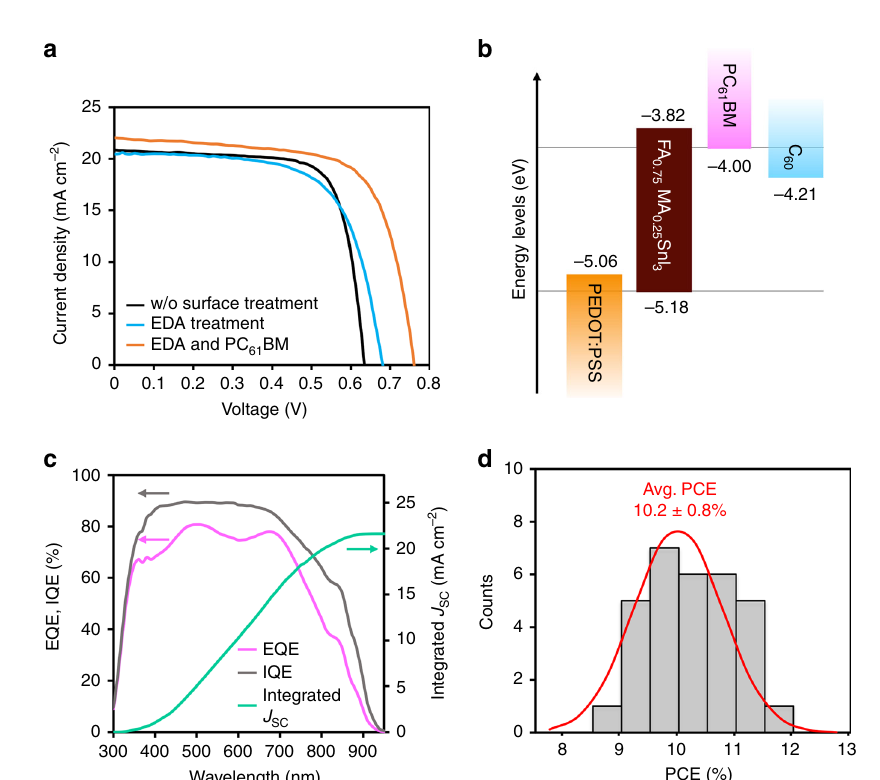
Fig. 5 Solar cell device characterization after surface treatment. a J – V curves of Sn-based PSCs with or without surface treatment with EDA and PC 61 BM. b Energy levels diagram of the cell components. c EQE and IQE spectra of the best device with EDA and PC 61 BM treatment. d Statistics of the PCE distribution of 30